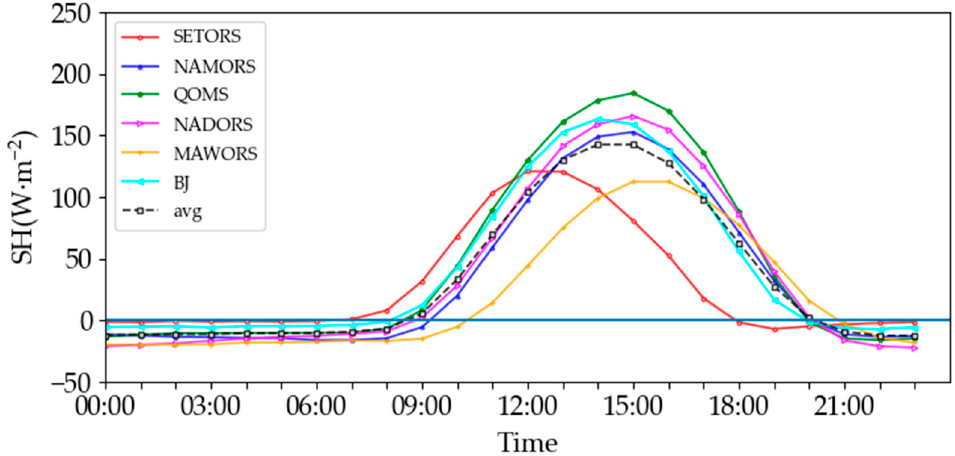
Figure 2. Climatological annual mean of diurnal variations of the observed SH (W m − 2 ) at six stations over the TP during the period 2006–2016. The colored lines represent SH at the six stations, respec- tively, and the black line indicates their average. The time in x axis is Beijing time.